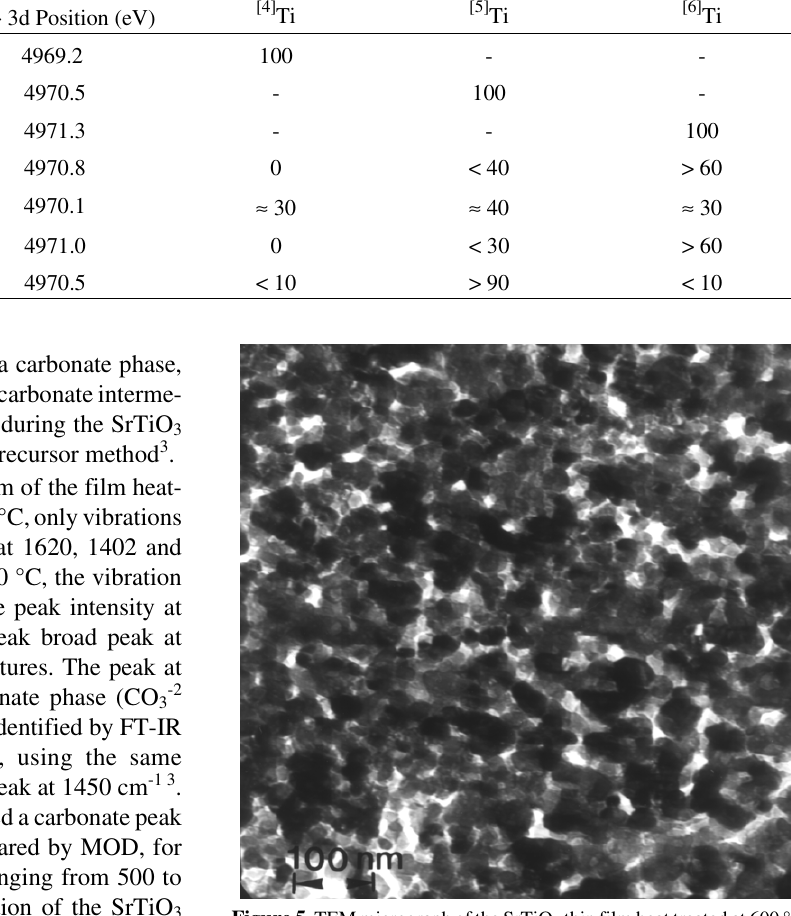
Figure 5. TEM micrograph of the SrTiO 3 thin film heat treated at 600 °C, 2